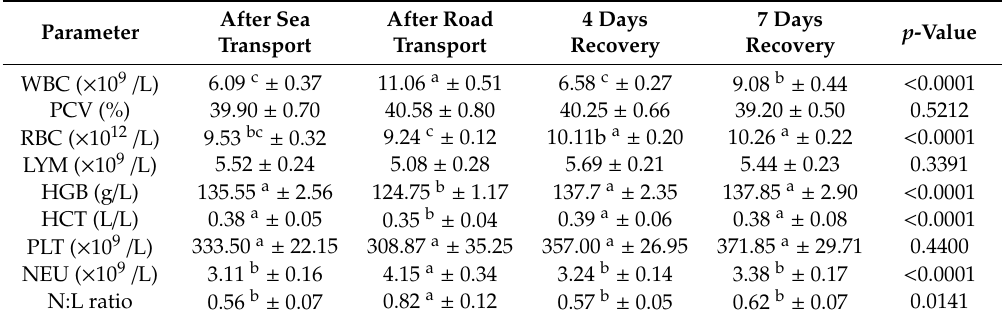
Table 2. E ff ects of sea and road transport on haematological parameters in cattle (Mean ± SE). After Parameter